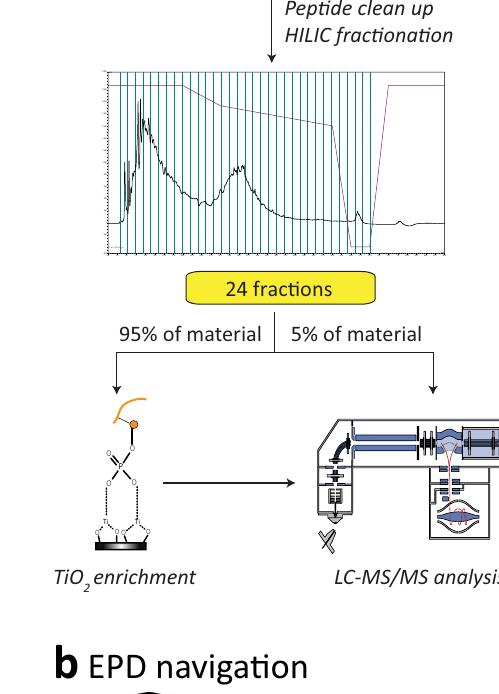
Next, we examined protein abundance changes in pathways previously connected to pig - 1 phenotypes. We found that proteins associated with asymmetric cell division, such as the centralspindlin complex-forming ZEN-4 (Zygotic epidermal ENclosure defective) and CYK-4 (CY to Kinesis defect) (reviewed in ref. 44), were more abundant in pig - 1 mutant embryos (Fig. 5d). Further examples include the > 3.5-fold higher abundances detected for GPR-2 (G Protein Regulator) and LIN-5 (abnormal cell LINeage), the orthologues of Drosophila PINS (Partner of INScuteable) and NuMA (Nuclear Mitotic Apparatus protein), respectively. GPR-2 and LIN-5 mediate the formation of differently sized daughter cells via microtubule-cortex interactions in the C . elegans one-cell embryo (for review see ref. 1). We also observed that Wnt signalling components, such as the Wnt recep- tor MOM-5 (MOre of MS) and DSH-2 (DiSHevelled related), showed higher abundance in pig - 1 mutant embryos (Fig. 5d). Furthermore, as pig - 1 genetically interacts with the apoptosis pathway (Fig. 2c, refs 8, 14, 15) and as pig - 1 was suggested to promote the digestion of apoptotic cells 14 , we examined proteins related to cell death and corpse engulfment. We found that the apoptosis proteins CED-3 and CED-4 and the corpse engulfment proteins